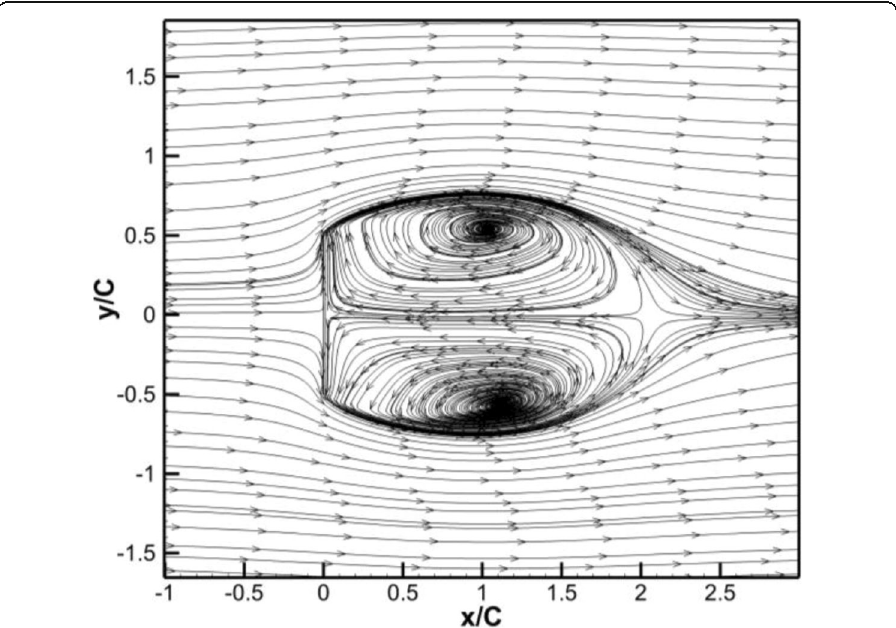
Fig. 1 Schematic of a bubble generated behind a normal flat plate (obtained from current simulation at Re =